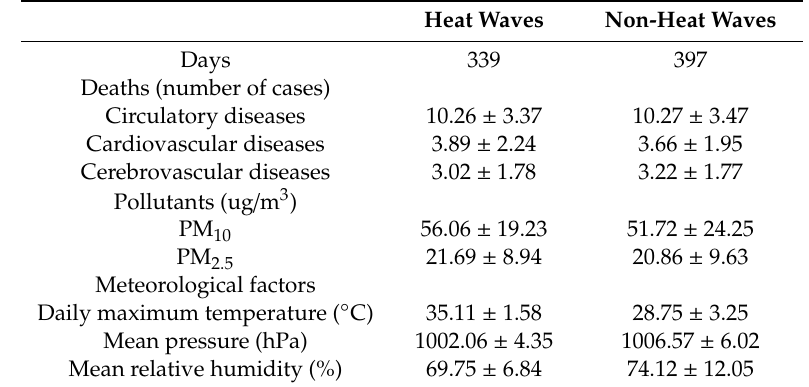
Table 1. Summary statistics of daily circulatory diseases deaths, particulate matter, and meteorological factors in Fuzhou during days with heat waves and days without heat waves during the warm season, 2016–2019.